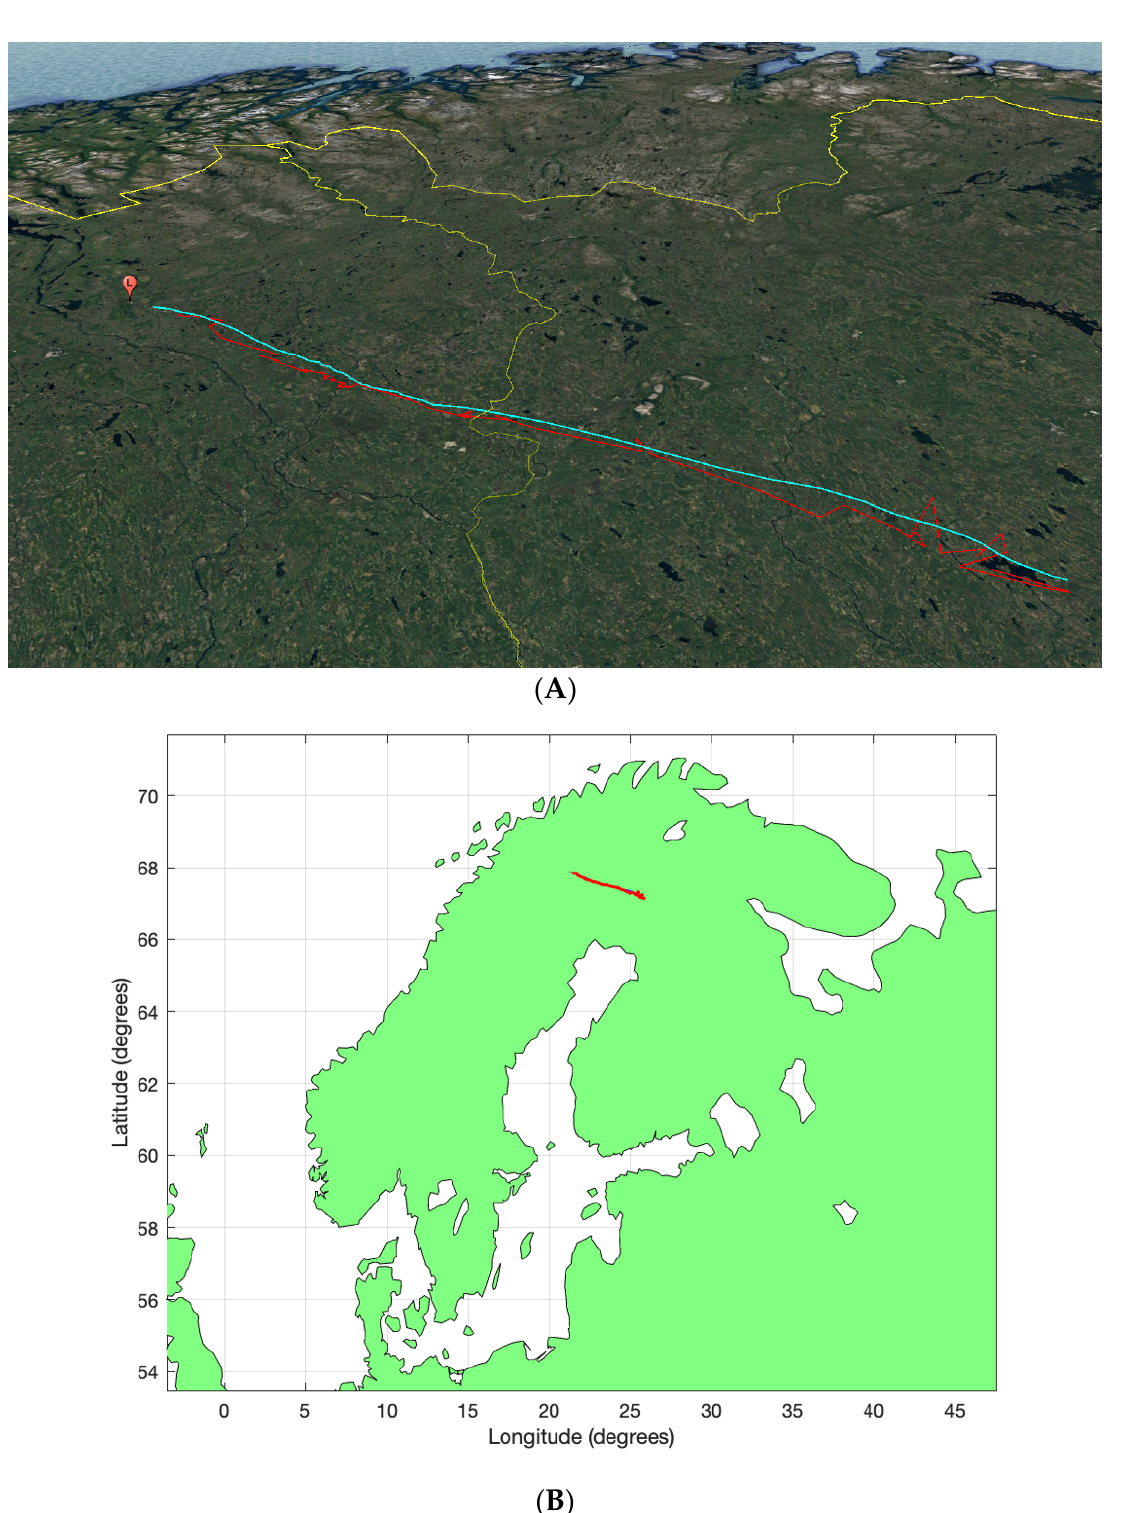
Figure 3. GPS (blue) and VOR-based (red) ground tracks displayed on a map (plot A ), location map with balloon trajectory in red (plot B ).